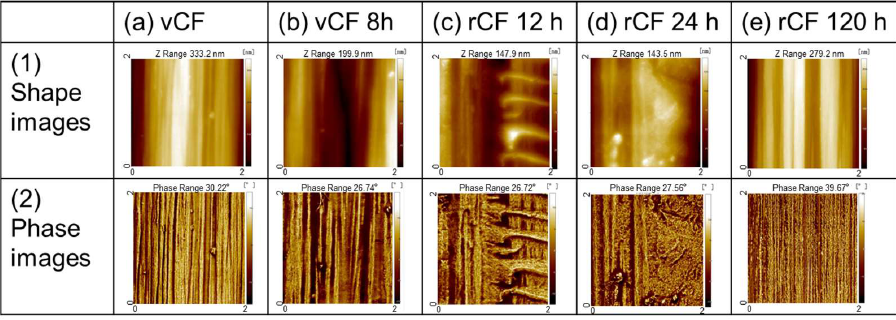
Figure A6. ( a ) Raman normalized spectra of the vCF and rCF surfaces using a 532 nm laser meas- ured under 0.2 mW; ( b ) curve fitting results of Raman normalized spectra for vCF. Appendix B Table A1. Shape factor in the Weibull function and scale factors taken for vCF and rCF. Shape Factor, m